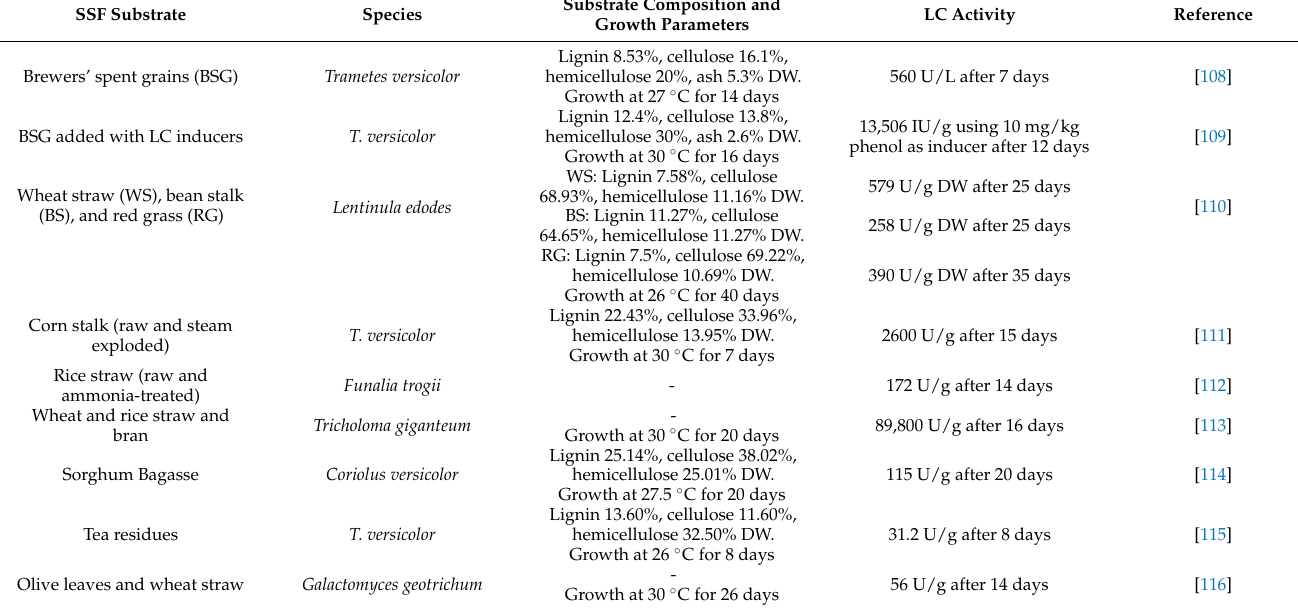
Table 1. Laccase production by solid state fermentation (SSF) on sustainable